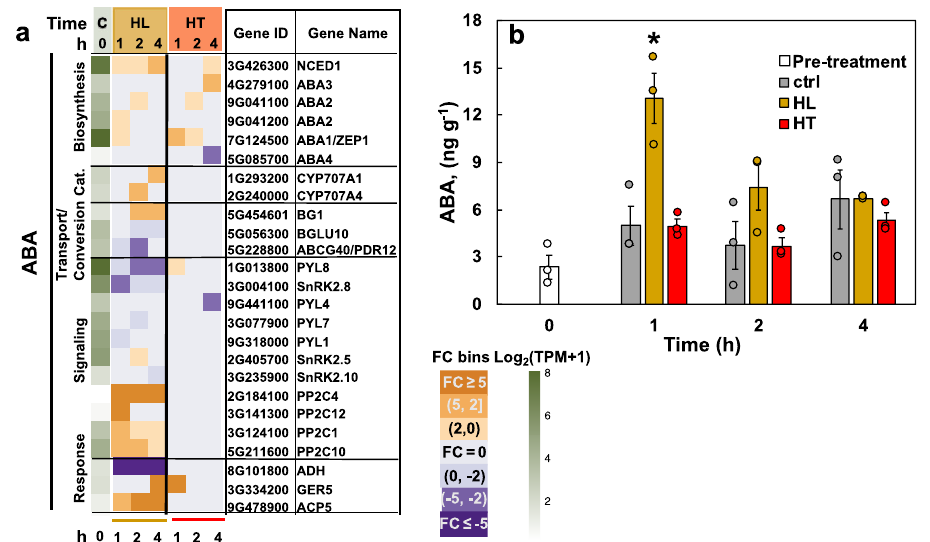
Fig. 5 High light up-regulated genes involved in the abscisic acid (ABA) pathway and transiently increased leaf ABA levels. a Heatmap of differentially regulated genes involved in the ABA pathway. Cat: catabolism. The fi rst green column displays log 2 (mean TPM + 1) at ctrl_0h (at the start of treatments, C). TPM, transcripts per million, normalized read counts. Heatmap displays the fold change (FC) bin of DeSeq2 model output values at 1, 2, and 4 h of high light or high temperature versus control at the same time point ( q < 0.05). FC bins: highly induced: FC ≥ 5; moderately induced: 5 > FC ≥ 2;